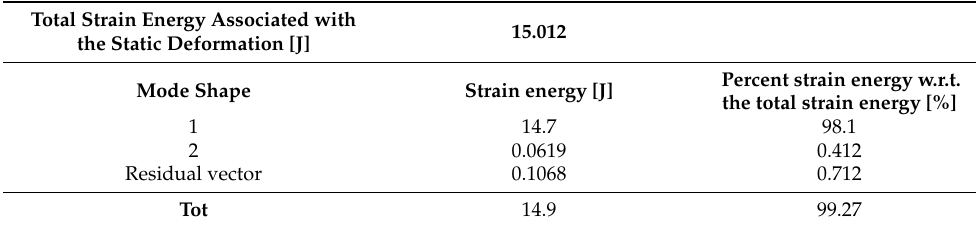
Figure 9. Percent strain energy of the first 20 mode shapes (and of the first residual vector, 21st among the calculated ones). Table 4. Detail of the chosen mode shapes.